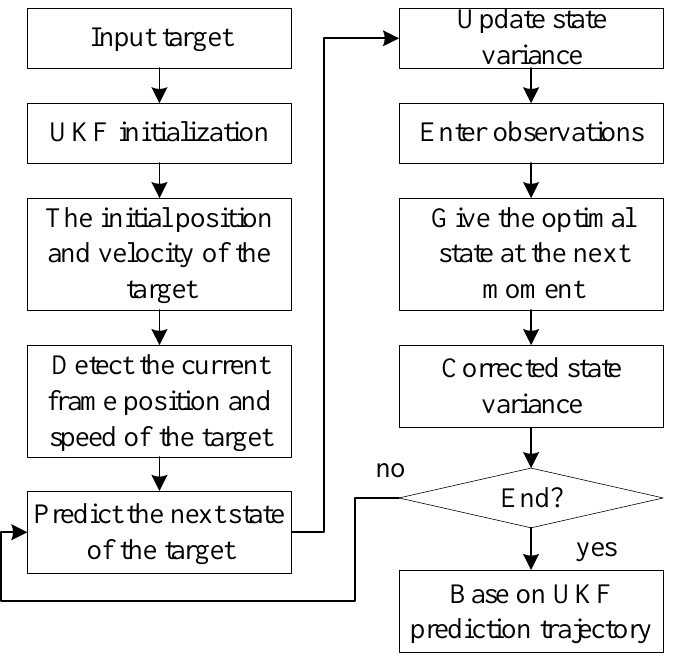
Figure 4. Target tracking process based on UKF algorithm. First, the ship target to be predicted and tracked is selected, and the UKF filter is initialized. Secondly, according to the initial position and velocity of the target and the detected target position and velocity of the current frame, the next state value of the target is predicted, and the state variance is updated. Then, the observed value of the next